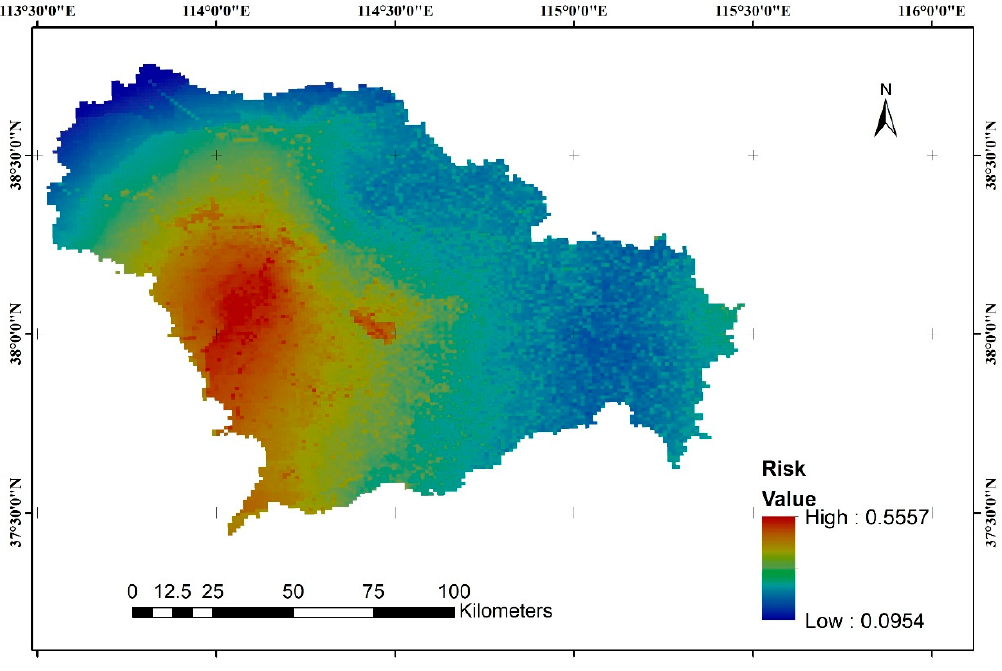
Figure 7. Flood risk map of Shijiazhuang.